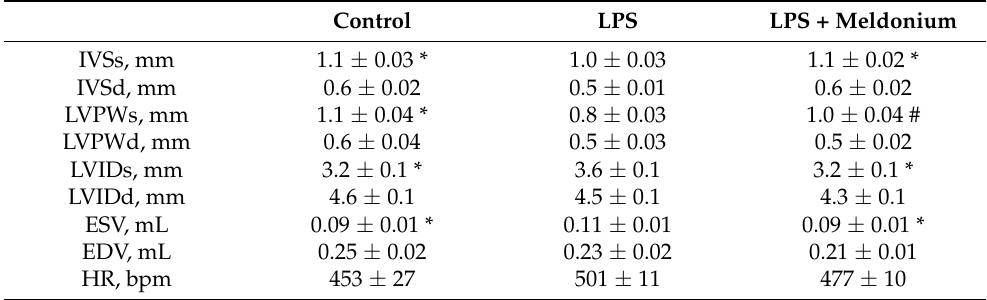
Heart rate (HR), left ventricular posterior wall thickness at end-systole (LVPWs), left ventricular posterior wall thickness at end-diastole (LVPWd), interventricular septal thickness at end-systole (IVSs), interventricular septal thickness at end-diastole (IVSd), left ventricular internal dimension at end-systole (LVIDs), left ventricular internal dimension at end-diastole (LVIDd), end systolic volume (ESV) and end diastolic volume (EDV) of the animals from all three groups. The data are shown as the mean ± SEM of 7 to 8 animals. # p < 0.07 vs. the LPS group, one-way ANOVA with Dunnett’s multiple comparison test, * p < 0.05 vs. the LPS group, one-way ANOVA with Dunnett’s multiple comparison test.